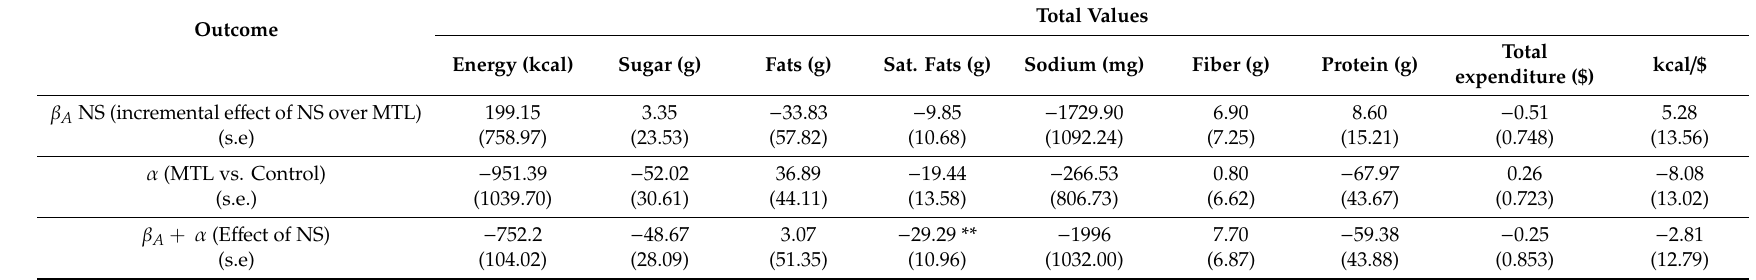
Table A2. Regression with total value outcomes ( N = 292, n =